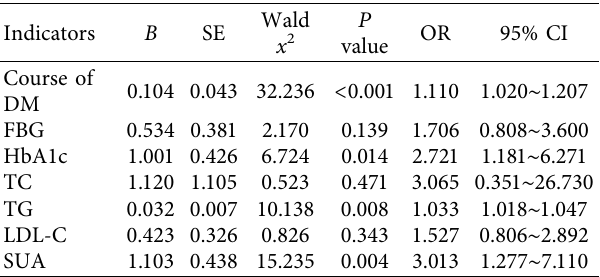
P Wald OR 95% CI x 2 value